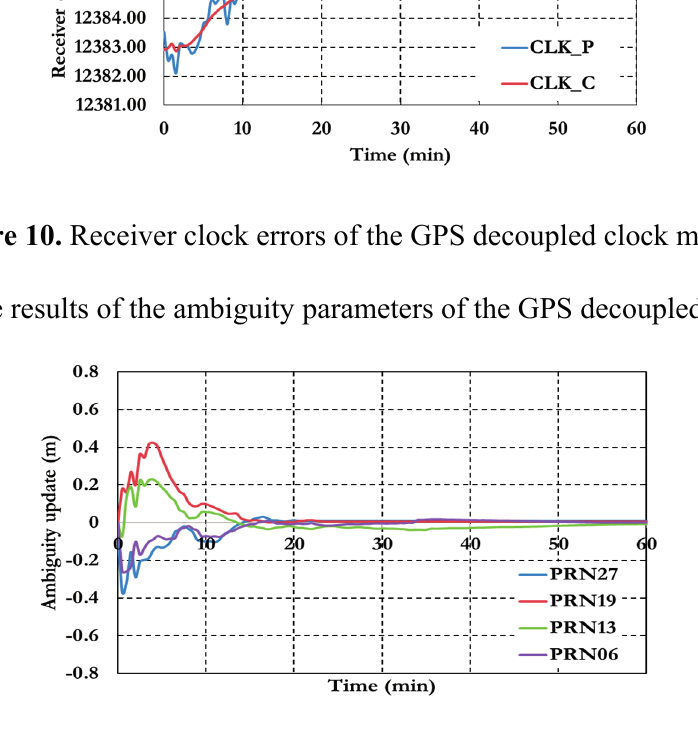
Figure 11. Ambiguity parameters of the GPS decoupled clock